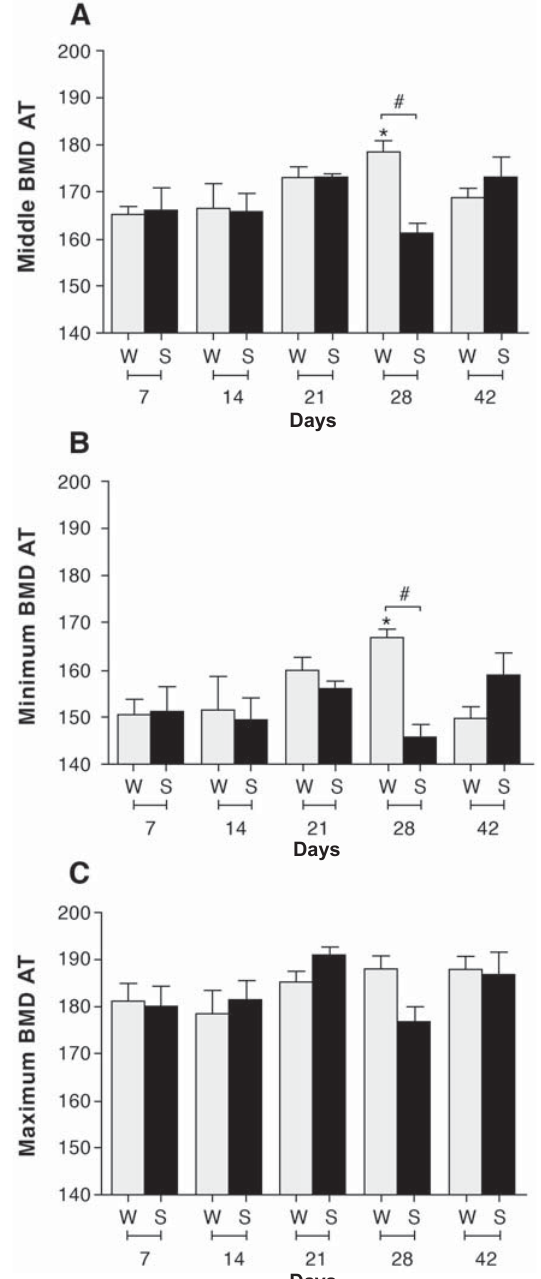
Figure 2- Bone mineral density (BMD) in the middle third (MT) of the alveolus. A) Middle BMD, B) Minimum BMD, (cid:2)(cid:3)(cid:4) (cid:5)(cid:6)(cid:7)(cid:8)(cid:9)(cid:10)(cid:9)(cid:4) (cid:11)(cid:5)(cid:12)(cid:13)(cid:4) (cid:14)(cid:12)(cid:8)(cid:15)(cid:15)(cid:16)(cid:17)(cid:16)(cid:18)(cid:19)(cid:16)(cid:4) (cid:6)(cid:9)(cid:20)(cid:18)(cid:21)(cid:4) (cid:22)(cid:20)(cid:23)(cid:24)(cid:20)(cid:22)(cid:16)(cid:17)(cid:6)(cid:24)(cid:8)(cid:25)(cid:16)(cid:4) days of Wistar rats (Medium and maximum BMD: 28x7,